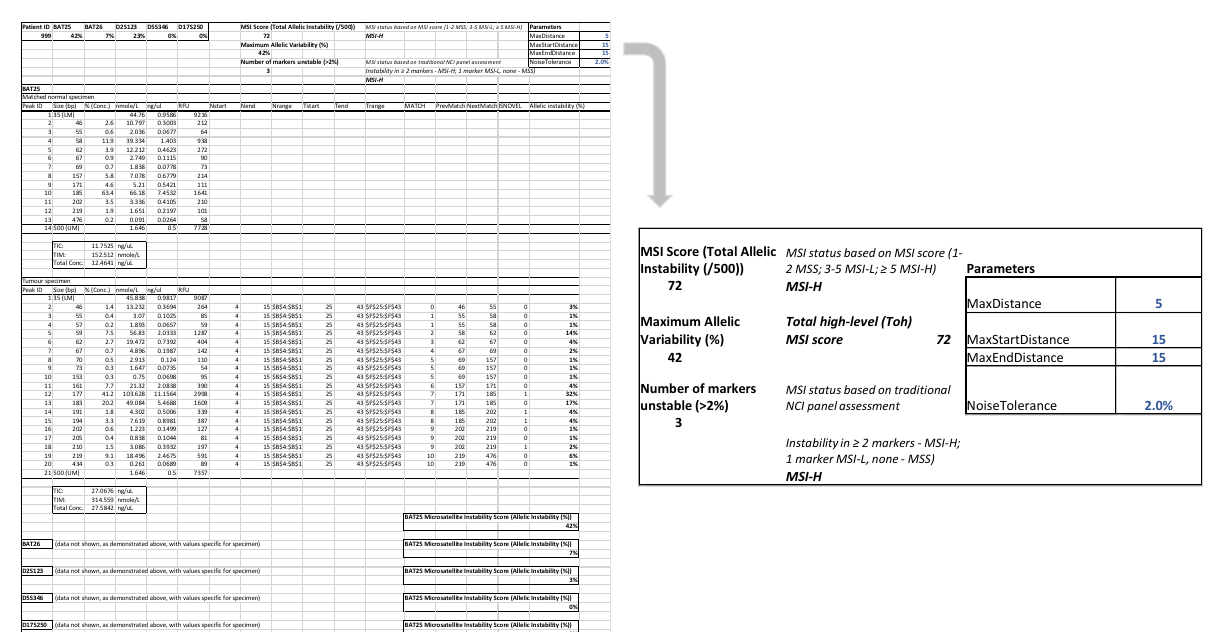
Figure 4. Automatic computation methods for MSI status determination based on allelic instability using both a traditional assessment of NCI panel (0/1/ ≥ 2 markers unstable corresponding to MSS/MSI-L and MSI-H respectively) and an MSI scoring system (total allelic variability 1–2/3–5/>5 corresponding to MSS/MSI-L and MSI-H). This tumour specimen was considered MSI-H with a Total high-level (Toh) MSI score of 72.